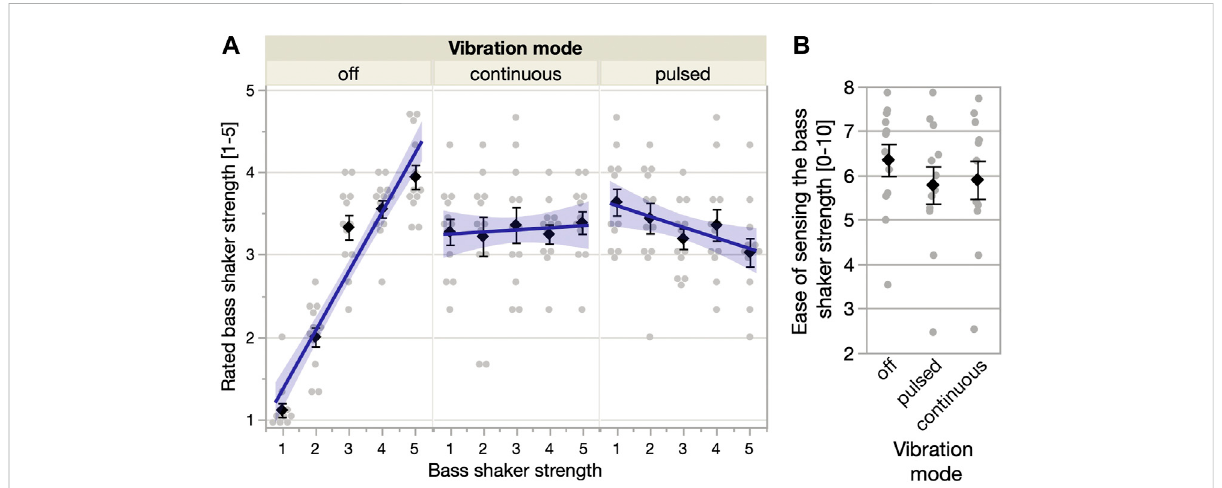
FIGURE 8 Study four results. (A) Perceived vs. actual bass shaker strength including linear regression fi ts, depending on whether thevibrotactorswere off, pulsed, or continuously vibrated. (B) Rated ease of sensing bass shaker strength depending on the vibrotactors ’ vibration mode.